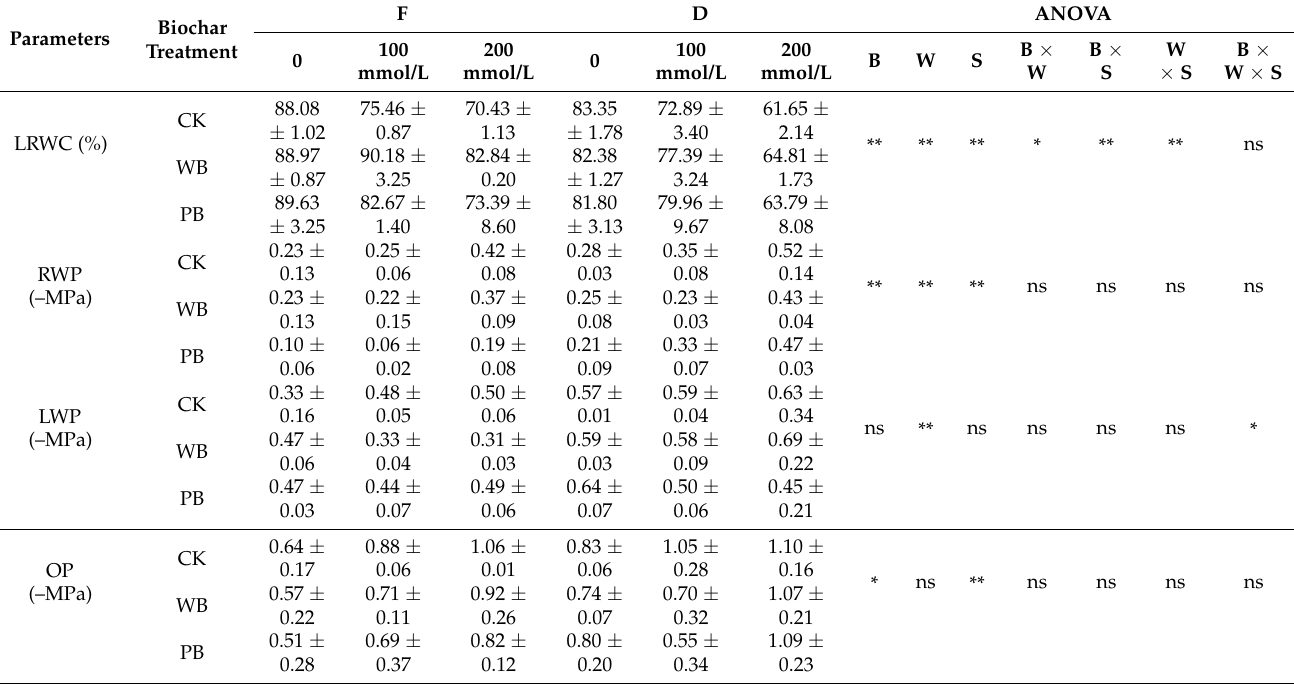
Table 4. Effect and output of three-way ANOVA for leaf relative water content (LRWC), leaf water potential (LWP), osmotic potential (OP), and root water potential (RWP) as affected by biochar addition (B), drought stress (W), and salt stress (S).